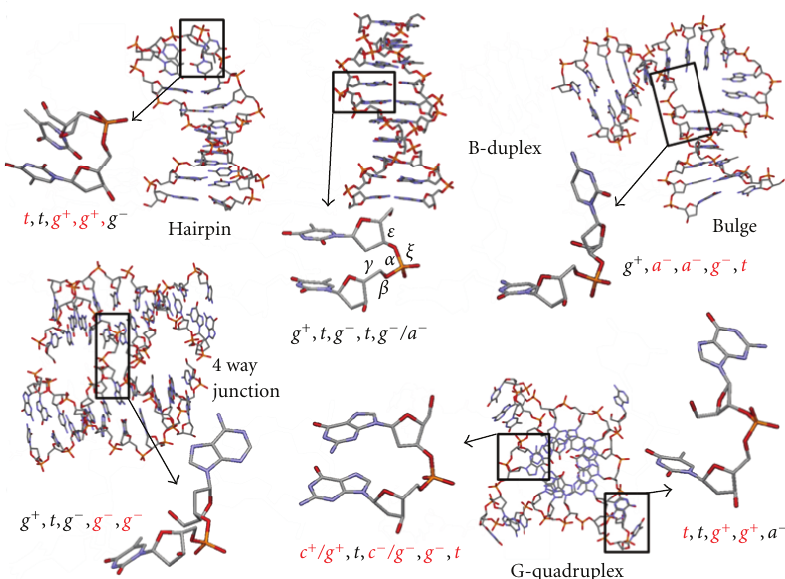
Figure 1: Examples of DNA secondary structures and associated backbone-torsion angles γ / β / α / ε / ζ of representative dinucleotide units. The following 6-fold staggered pattern of the torsional angles is used: cis = 0 ± 30 ◦ (c), gauche (+) = 60 ± 30 ◦ (g + ), anticlinal (+) = 120 ± 30 ◦ (a + ), trans = 180 ± 30 ◦ ( t ), anticlinal ( − ) = 240 ± 30 ◦ (a − ), and gauche ( − ) = 300 ± 30 ◦ (g − ). The notation g − /a − is used to designate a torsion angle on the border of gauche ( − ) and anticlinal ( − ). PDB ID: Hairpin, 1ii1; duplex, 436d; Bulge, 1jrv; 4-Way junction, 1zez, and G-quad, 1kf1.